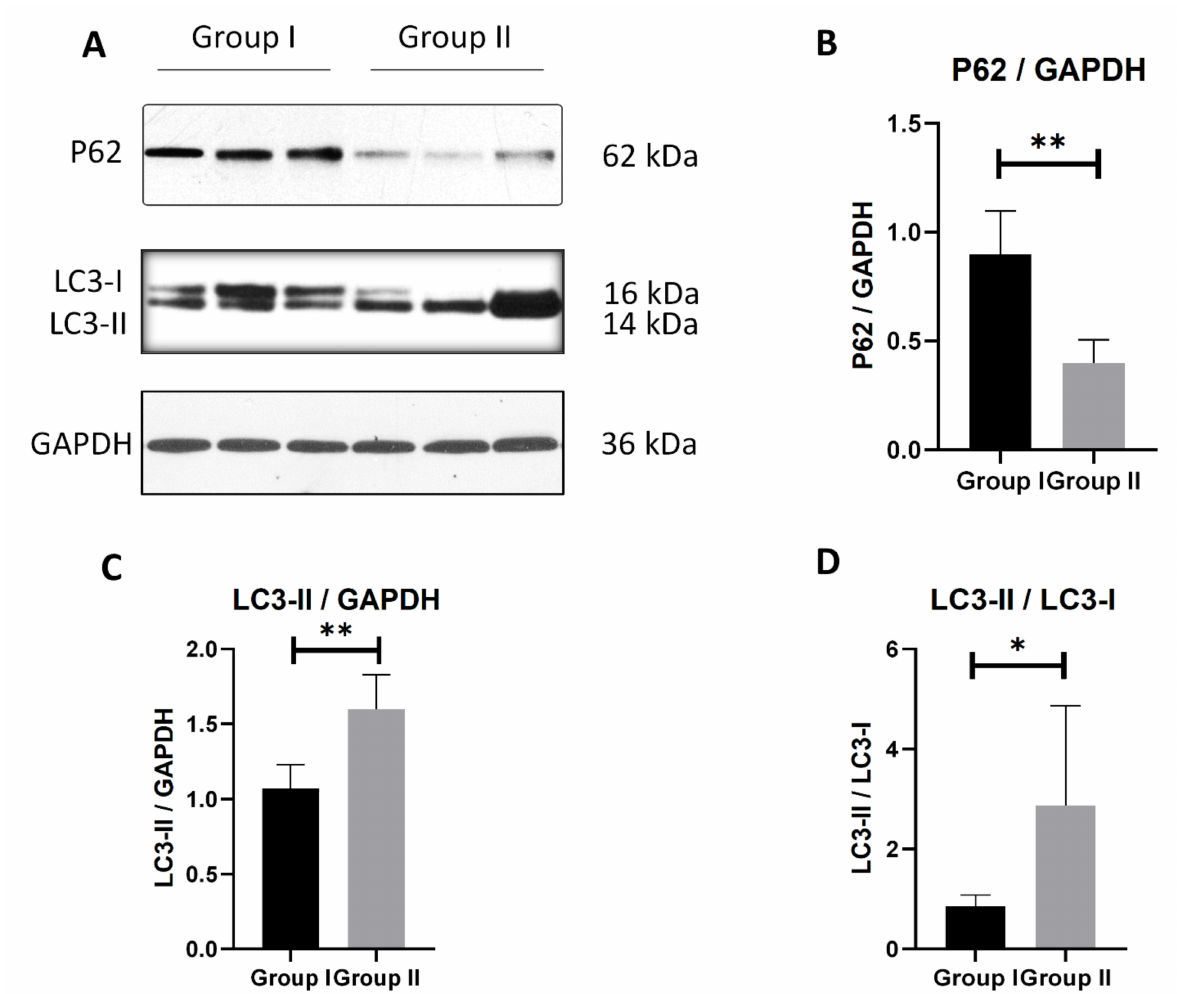
Figure 6. Representative immunoblots of mitophagy-related protein. ( A ) P62, LC3-I, LC3-II protein expression levels of the two groups. ( B ) Corresponding quantification of p62 to GAPDH. ( C ) Corresponding quantification of LC3-II to GAPDH. ( D ) Corresponding quantification of LC3-II to LC3-I. n = 6, * p < 0.05, ** p <